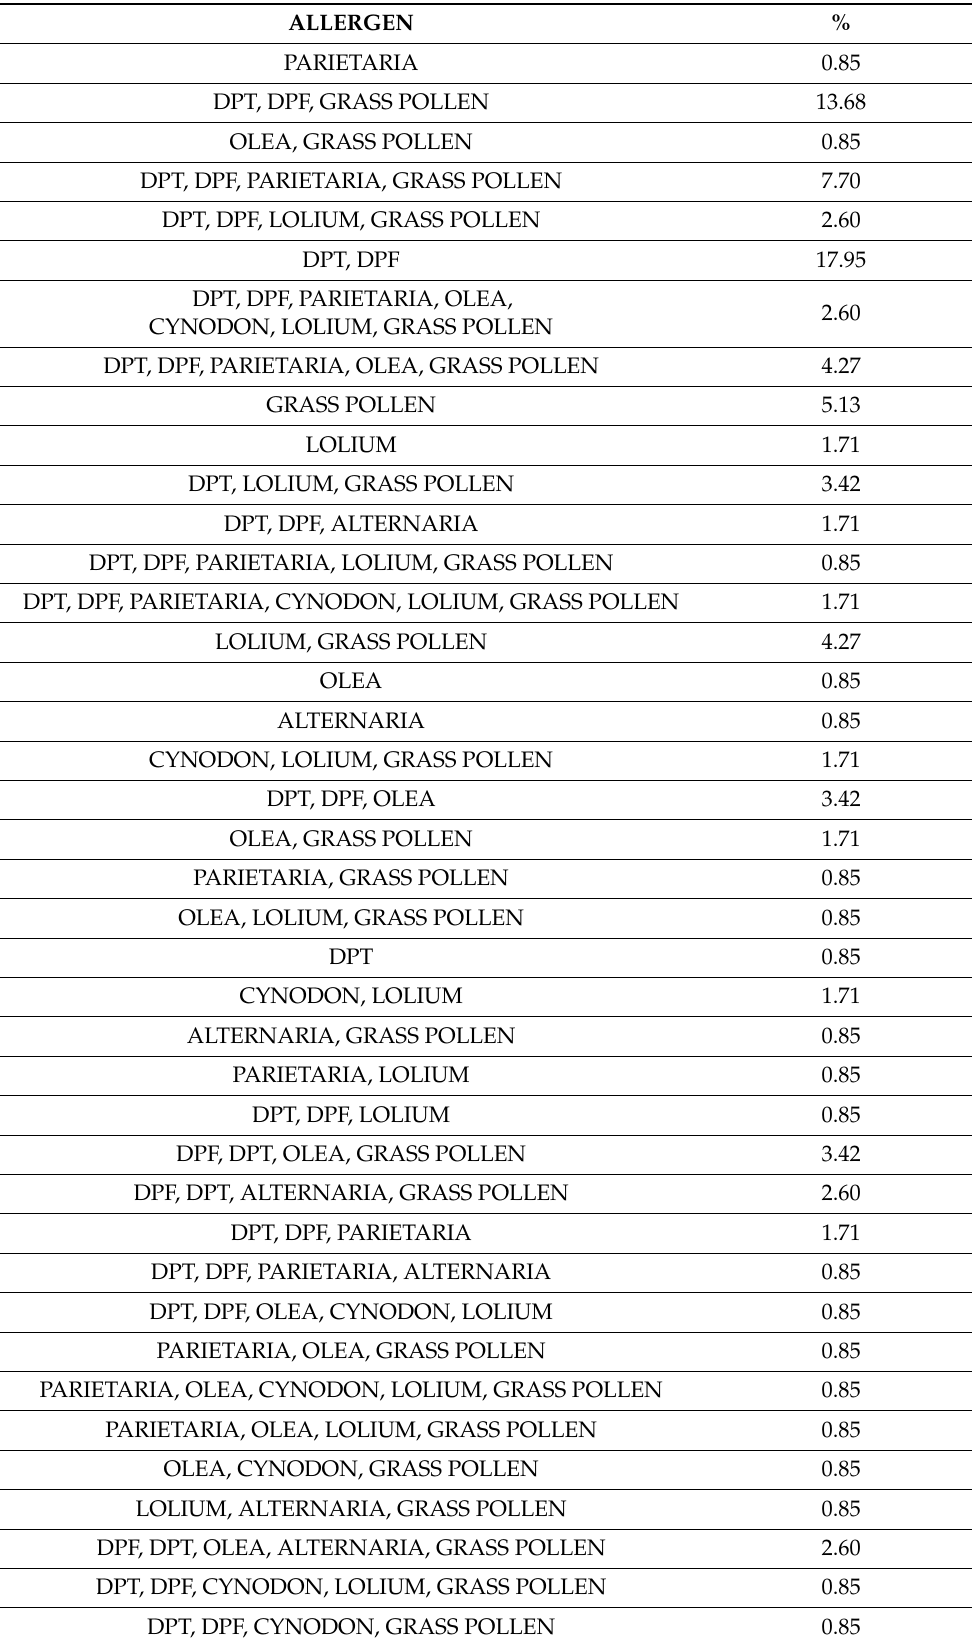
Table 1. Prevalent allergens in the study